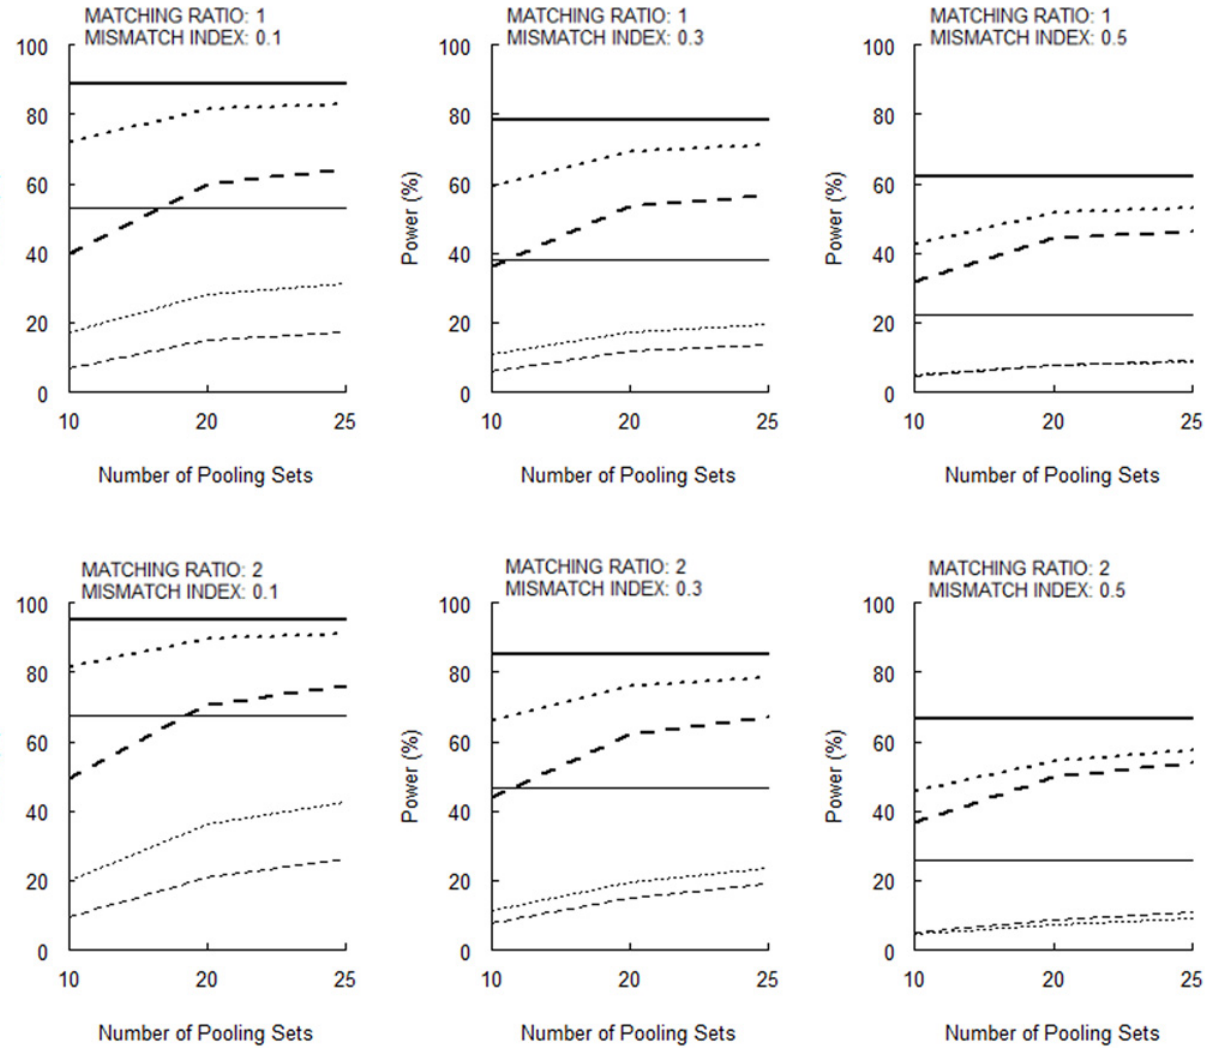
Fig 3. Powers of the permutation test with a total of 10 null markers (bold broken lines, σ = 0.05, α = 0.05; thin broken lines, σ = 0.05, α = 0.005; bold dotted lines, σ = 0.01, α = 0.05; thin dotted lines, σ = 0.01, α = 0.005). The horizontal bold and thin solid lines indicate the powers for the individual genotyping with stratum matching and genomic control for α = 0.05 and α = 0.005,